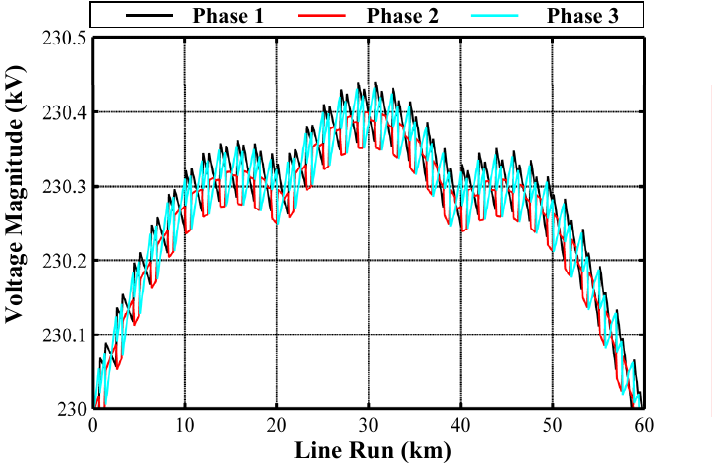
Figure 10. Phase voltage magnitudes along the compensated single-circuit cable in CB with PTs.